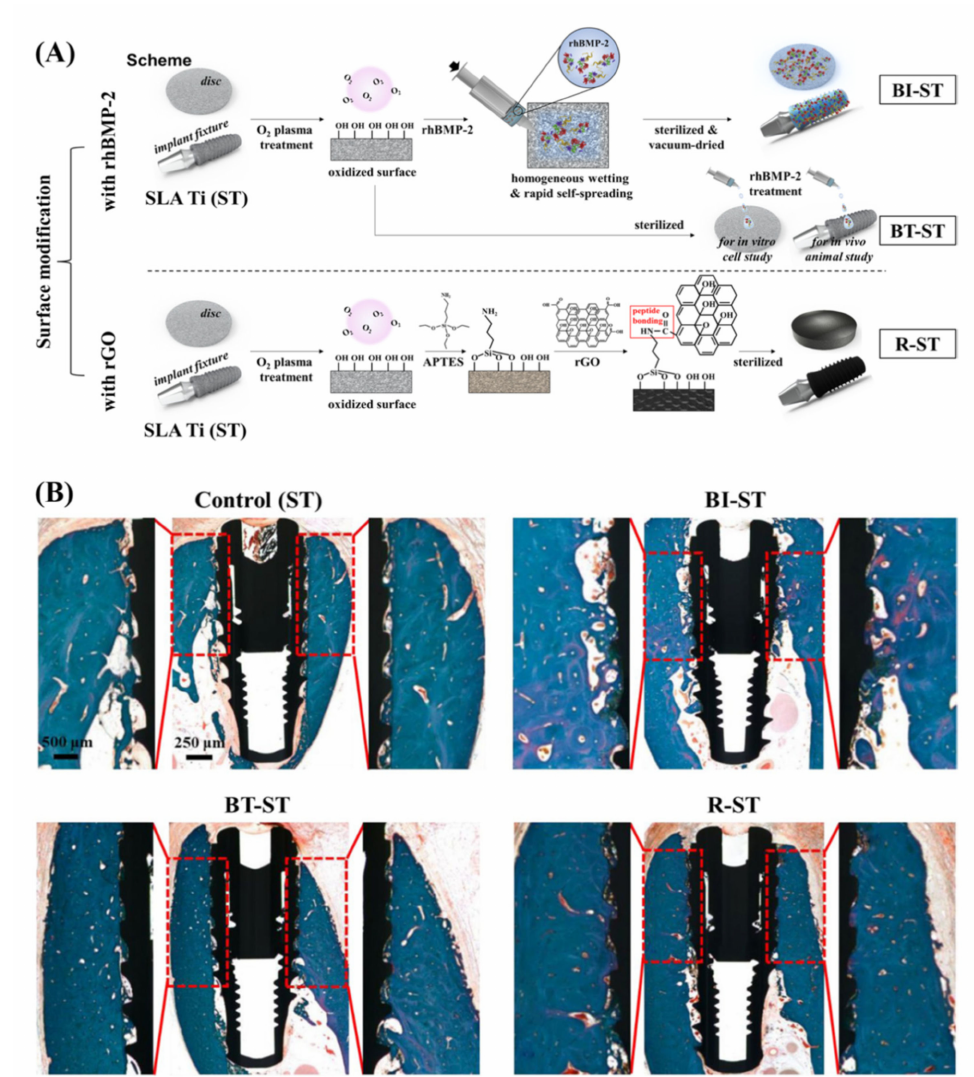
Figure 5. A reduced graphene oxide (rGO) coating enhanced the osseointegration of dental implants. ( A ) Scheme for surface modification of SLA Ti (ST) with rhBMP-2 immobilization (BI-ST) or treatment (BT-ST) and rGO coating (R-ST). ( B ) Histological assessment for osseointegration of implants via Goldner Trichrome staining; the region of interest for measurements of bone-to-implant contact length and intra-thread bone density is exhibited with higher magnification. [130] Copyright 2022, the